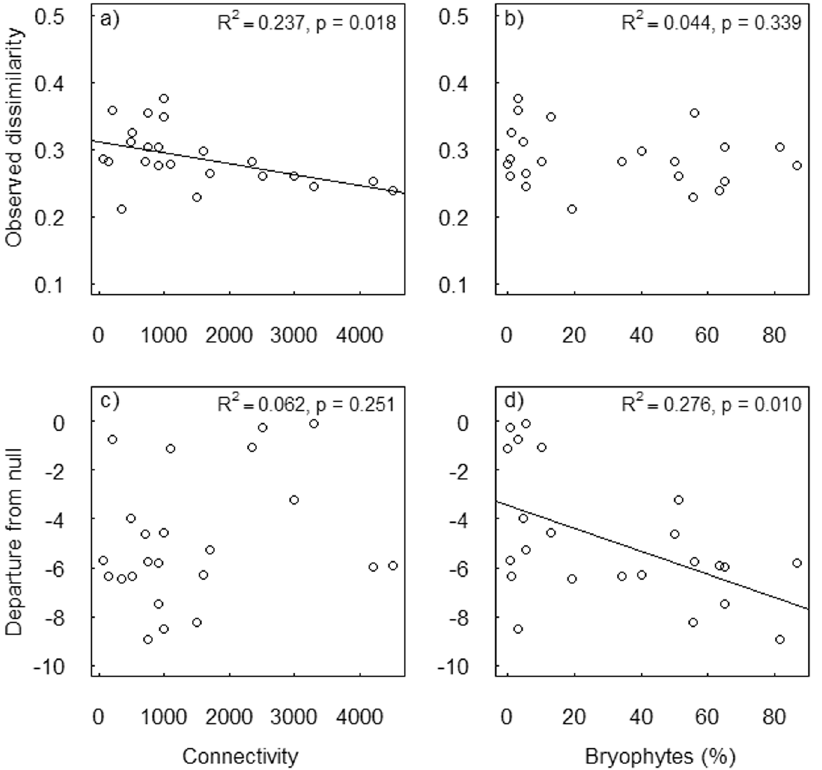
Figure 2. Regressions between temporal β diversity and selected environmental variables. Univariate linear regressions between the observed dissimilarity (top row: a&b) or deviation from the null expectation (bottom row: c&d) and connectivity (i.e. riffle area within a 500-m buffer of a study reach, m 2 ) and bryophyte